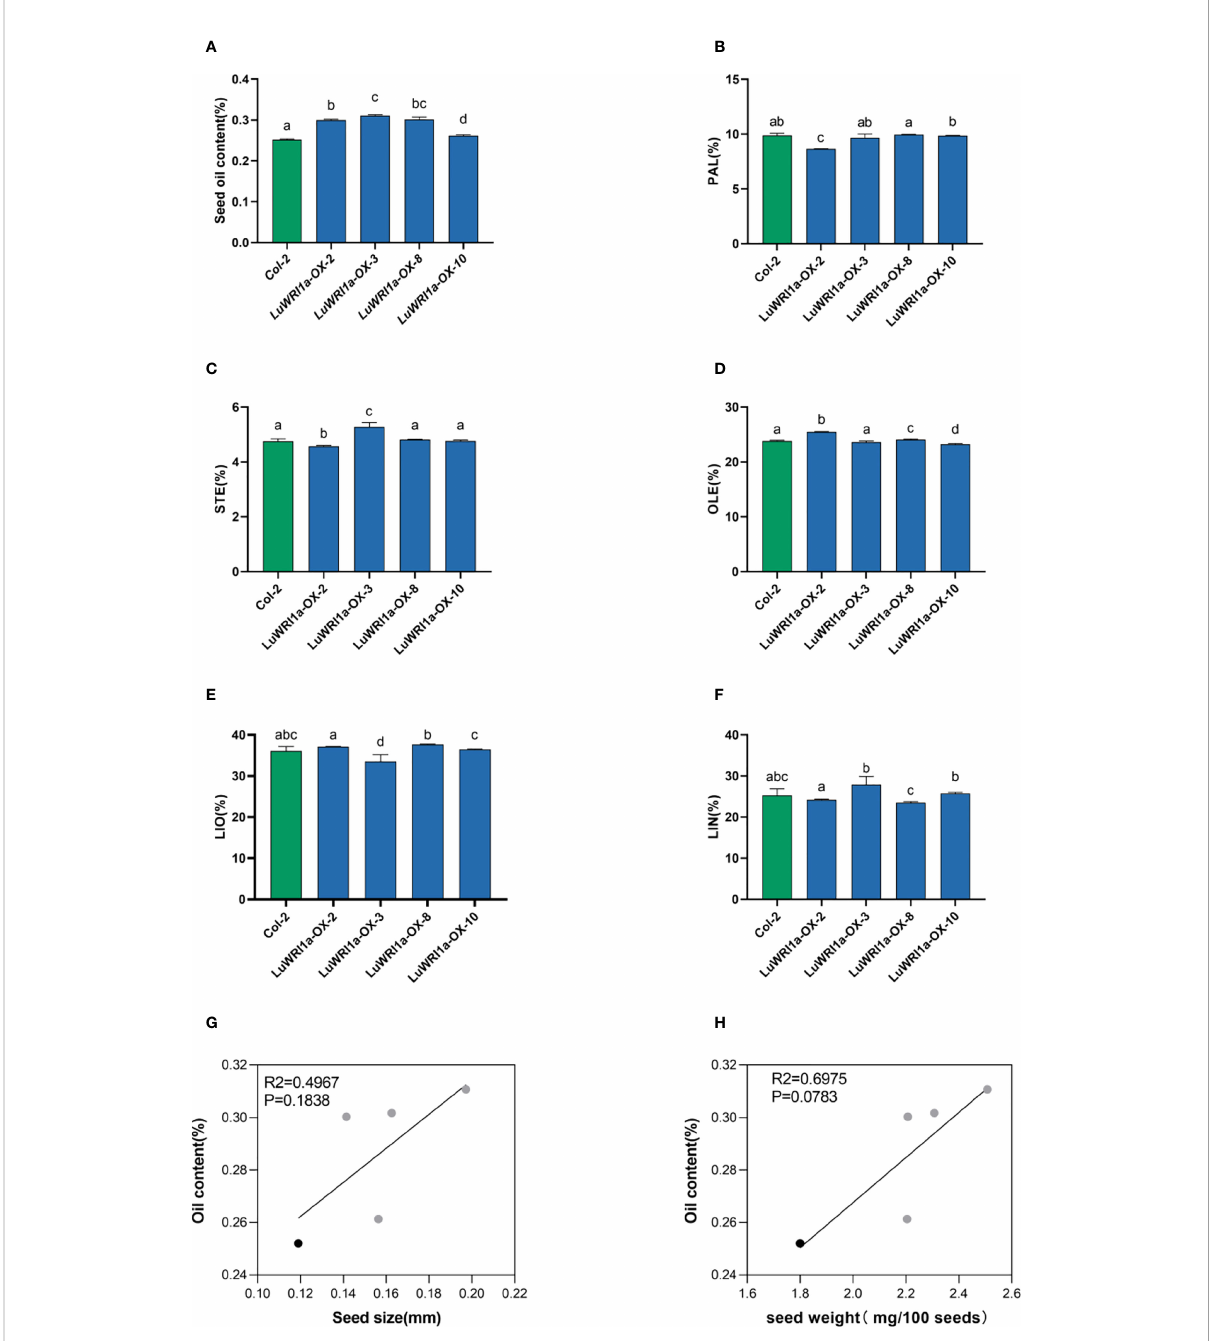
FIGURE 4 Overexpression of LuWRI1a in Arabidopsis seedlings enhanced oil content. (A) Transgenic LuWRI1a overexpression of Arabidopsis . Seed oil contents of four T3 homozygous LuWRI1a -overexpressing transgenic plants ( LuWRI1a-OX-X ) and null transgenic (Col-2). Error bars represent SD (n = 3). (B-F) . Summary of the fi ve major fatty acid pro fi les in the seeds of null transgenic (Col-2) and four T3 homozygous LuWRI1a - overexpressing transgenic plants ( LuWRI1a-OX-X ). Palmitic acid (PAL), stearic acid (STE), oleic acid (OLE), linoleic acid (LIO), and linolenic acid (LIN) are all fatty acids. Error bars represent SD (n = 4). (G) Correlative analysis of the oil content and seed size(mm) in null transgenic (black) and transgenic lines of fl ax (gray). (H) Correlative analysis of the oil content and seed weight(mg/100 seeds) in null transgenic (black) and transgenic lines of fl ax